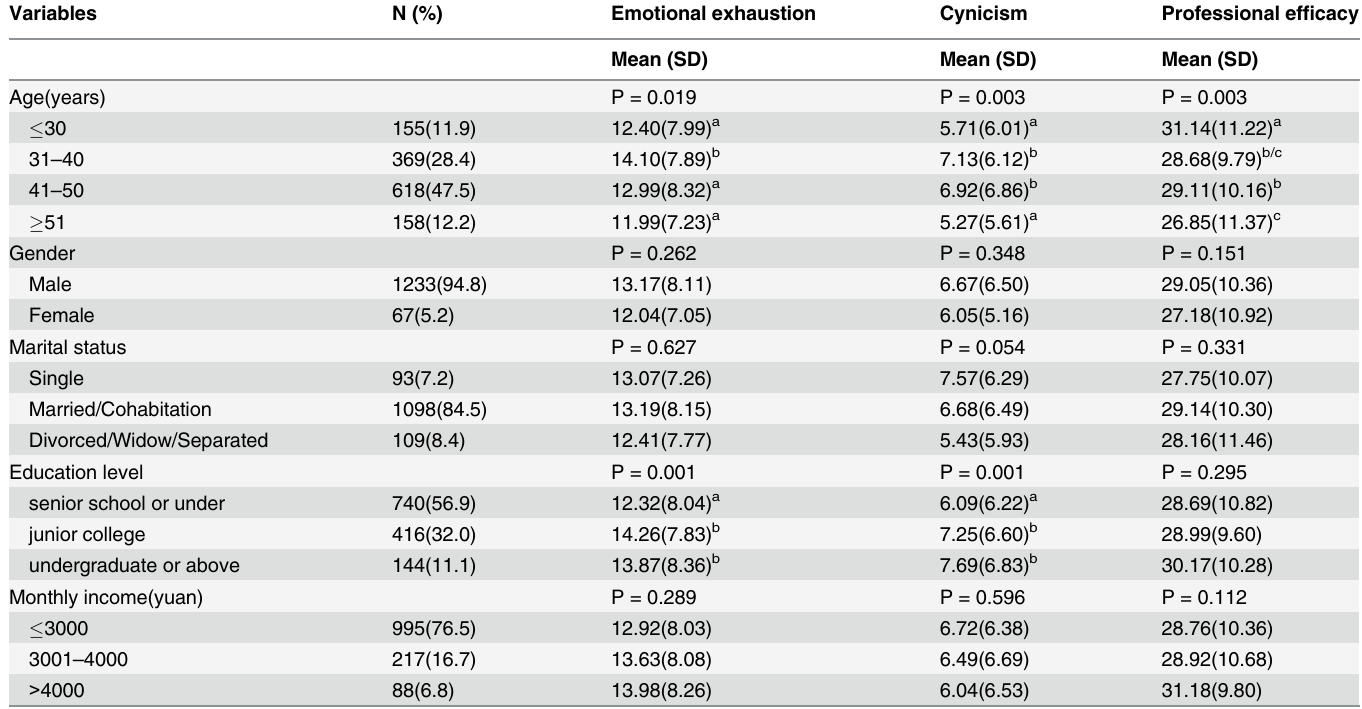
Table 1. Mean MBI-GS scores of iron and steel worker according to sociodemographic feature.